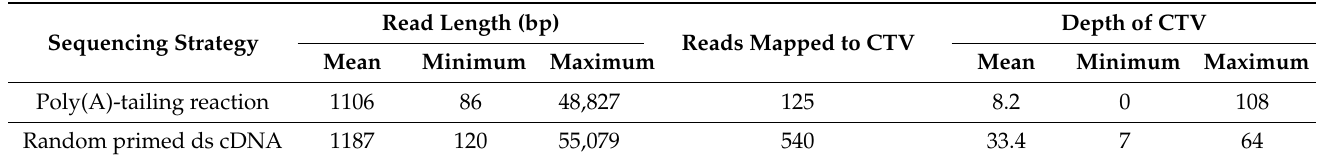
Table 1. Read and mapping summary of a subset of 460,000 reads generated from libraries prepared by either poly(A)-tailing reaction or from random primed double-stranded (ds) cDNA of citrus tristeza virus (CTV)-infected total RNA. Read Length Sequencing Strategy